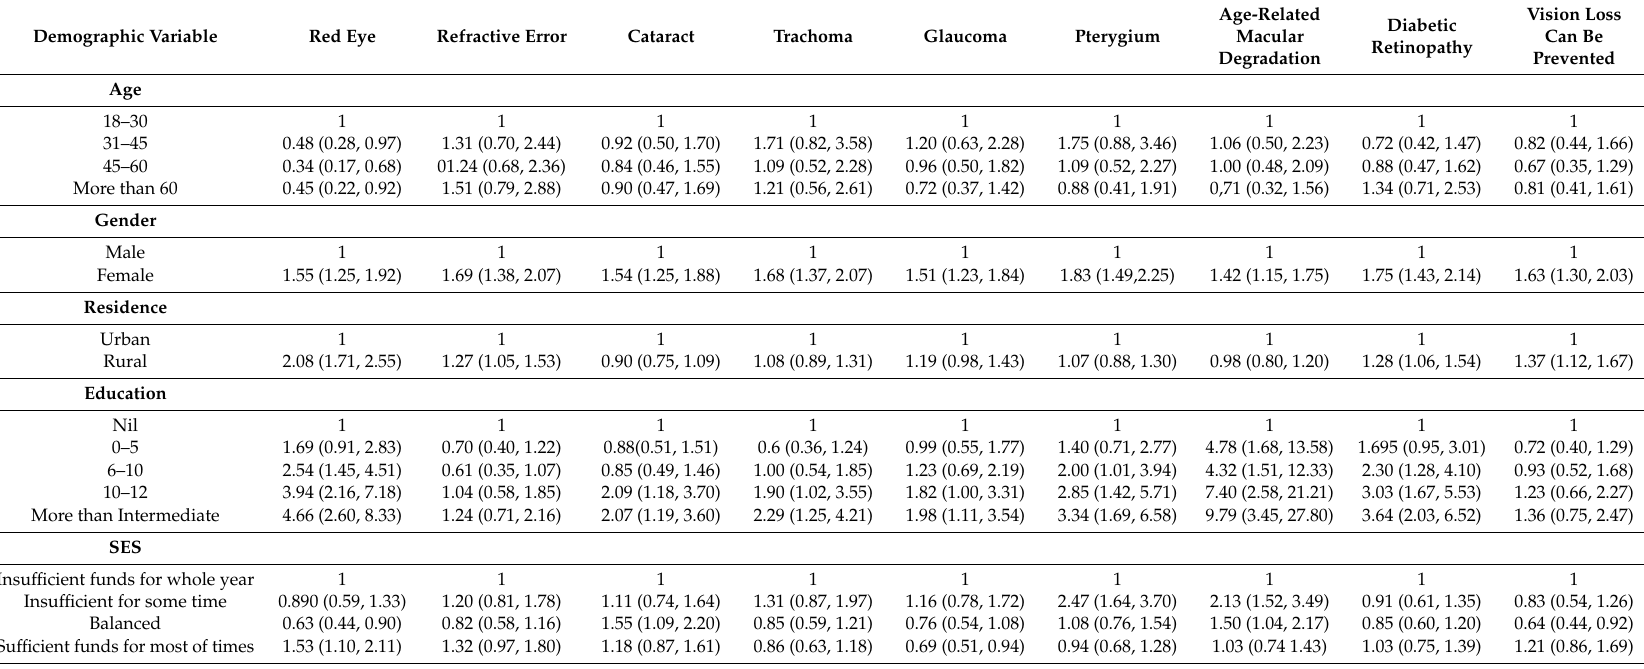
Table 3. Demographics of each eye-related problem (AOR, 95%CI Adjusted for Age, Gender, Locality, Education and